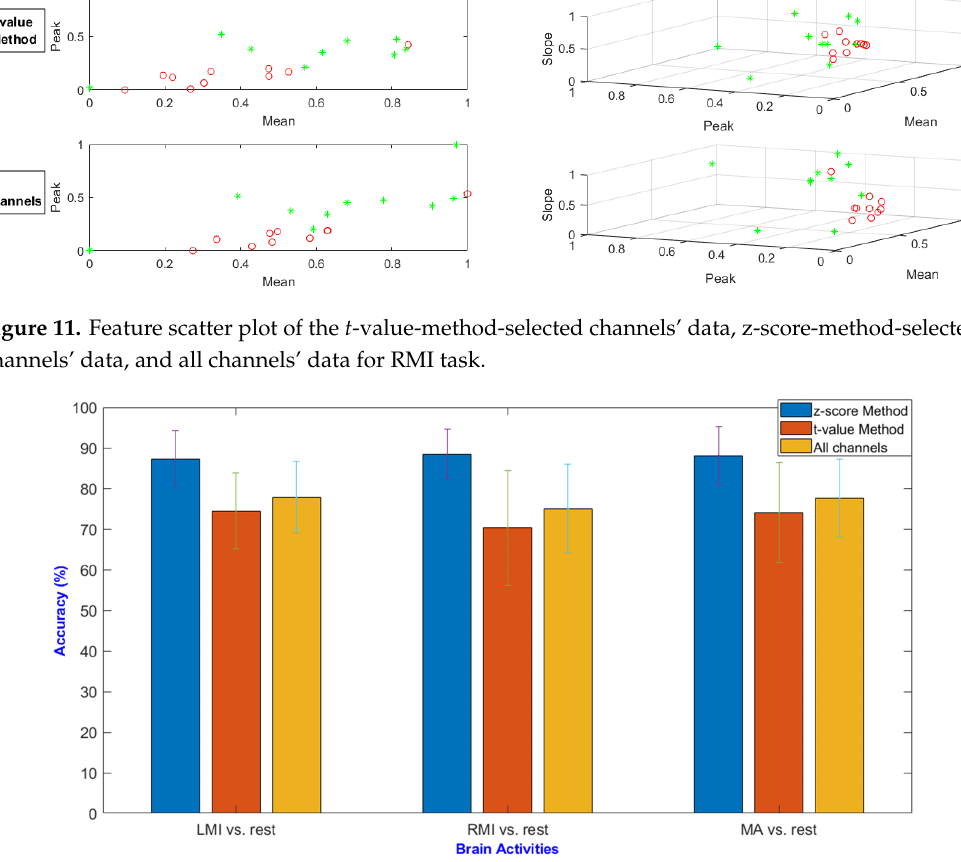
Figure 12. Average classification accuracies for the z-score method, t -value method, and all channels’